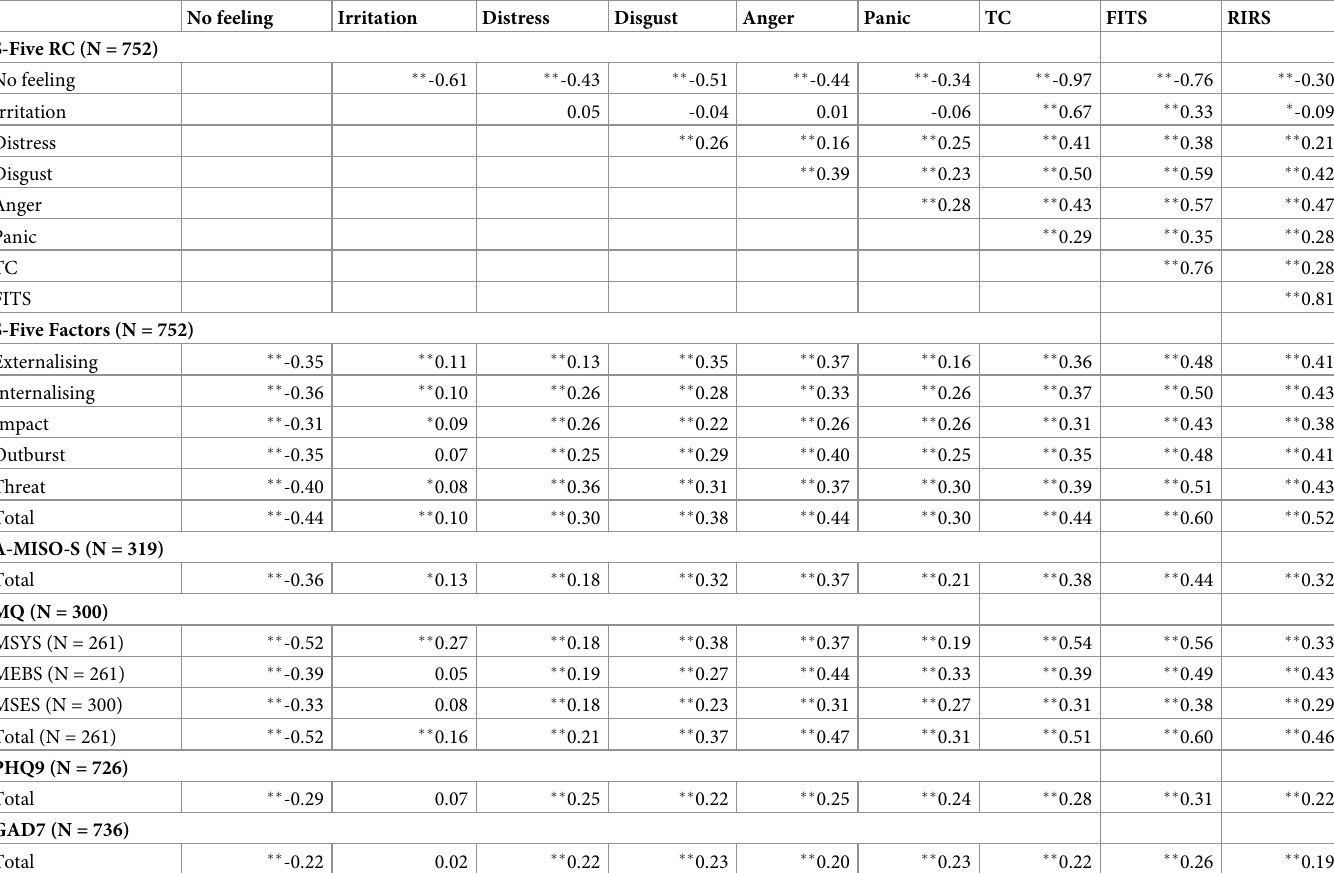
Table 5. Intercorrelations of the S-Five, S-Five-T scores, and correlations with other measures. No